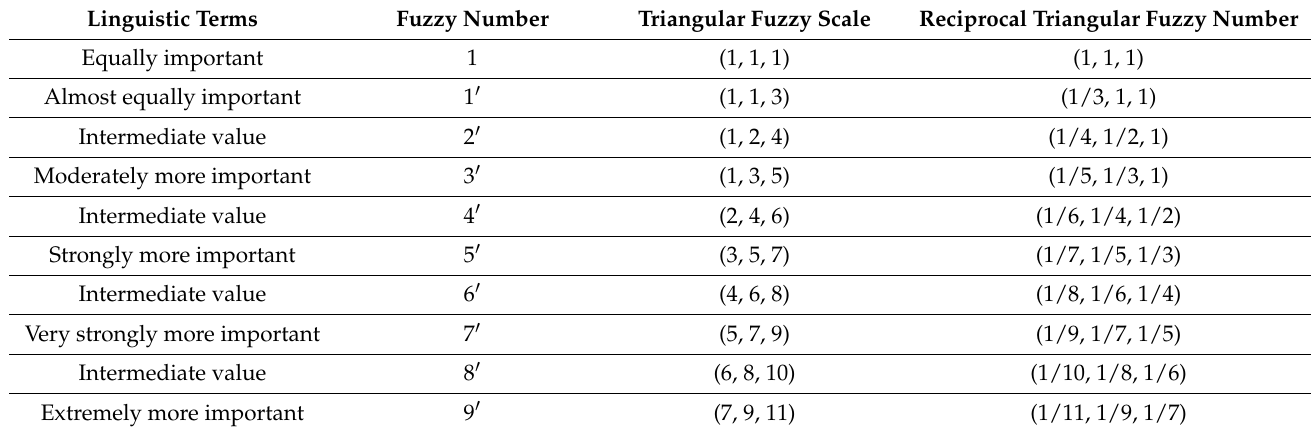
Figure 3. Triangular membership function. Table 2. Quantitative scale of triangular fuzzy number in